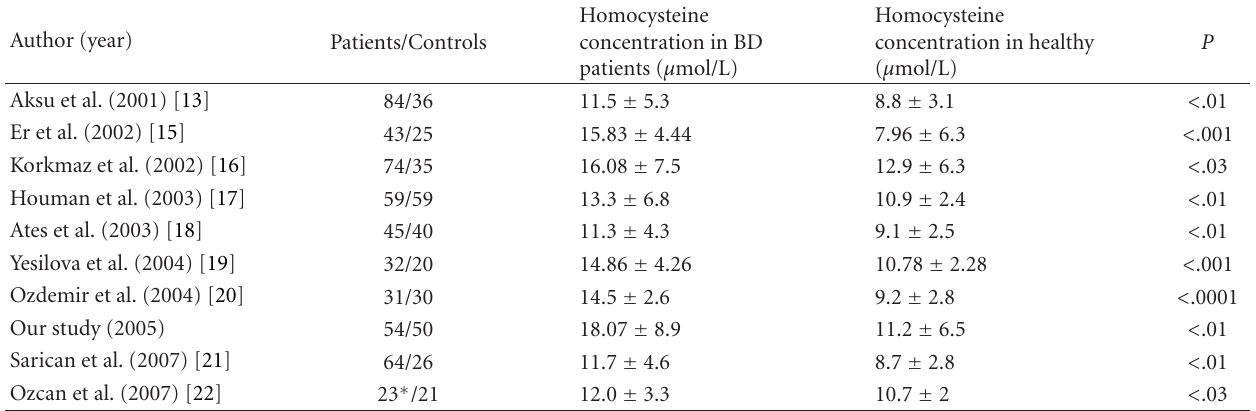
Table 4: Homocysteine and Behc¸et’s disease.